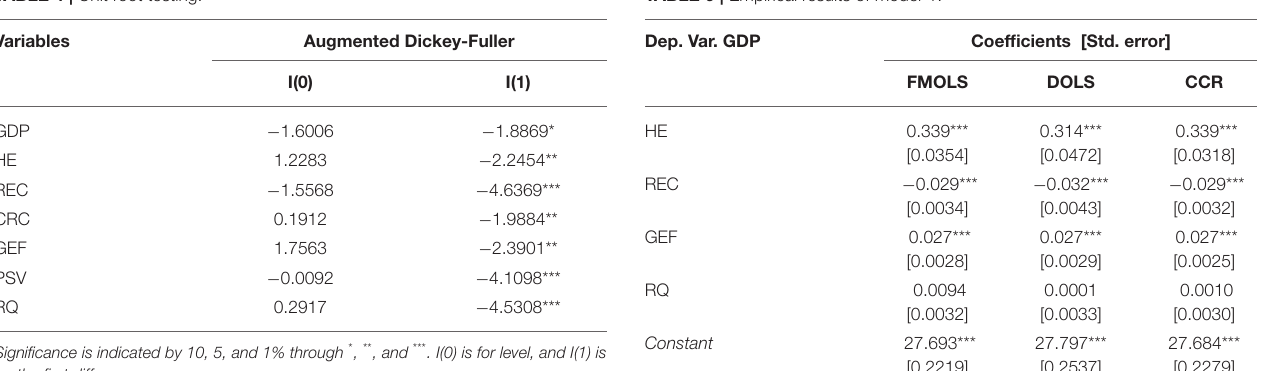
TABLE 6 | Empirical results of model-1.